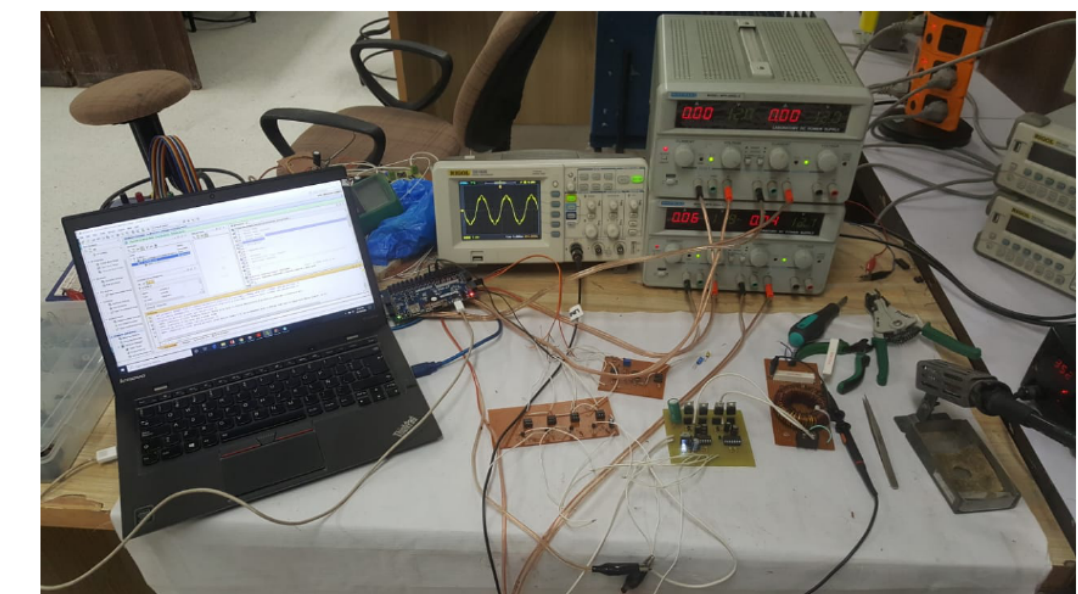
Figure 3. Experimental setup of the proposed technique.